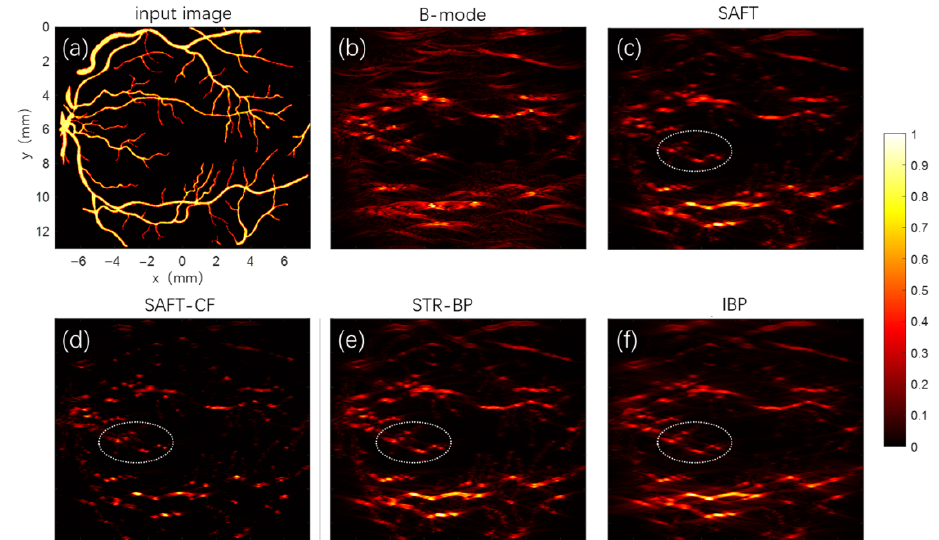
Figure 6. The reconstructed results of a digital blood vessel network with different methods. ( a ) The input digital blood vessel network and ( b – f ) the reconstruction results given by the B-mode, SAFT, SAFT-CF, STR-BP, and IBP methods, respectively.